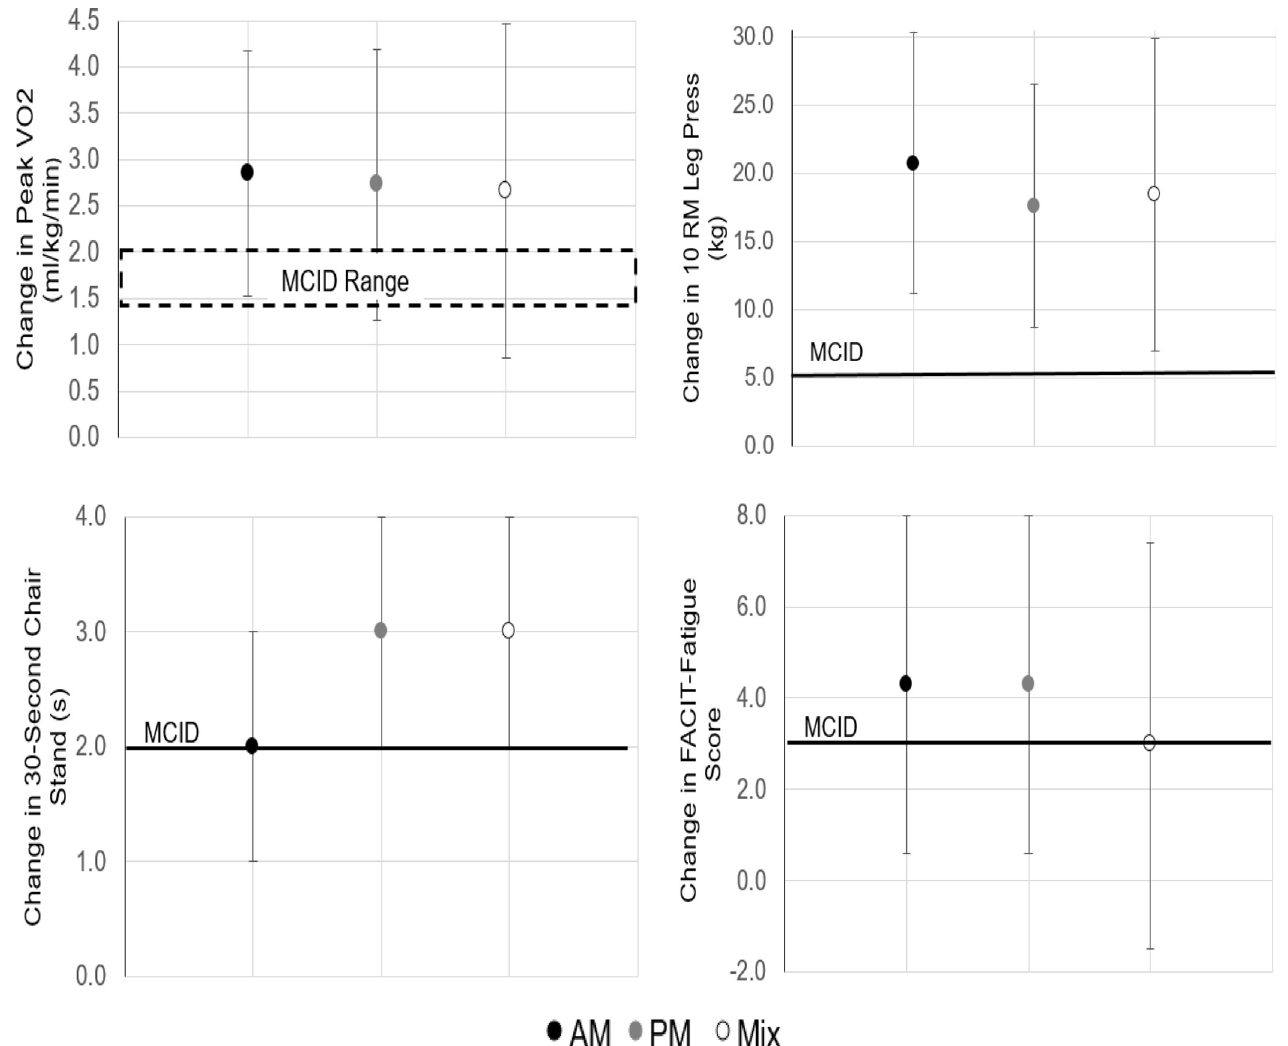
Fig 1. Statistically significant changes in health outcomes that exceeded the minimal clinically important difference (MCID) threshold for the total sample. Data presented as mean and 95% confidence